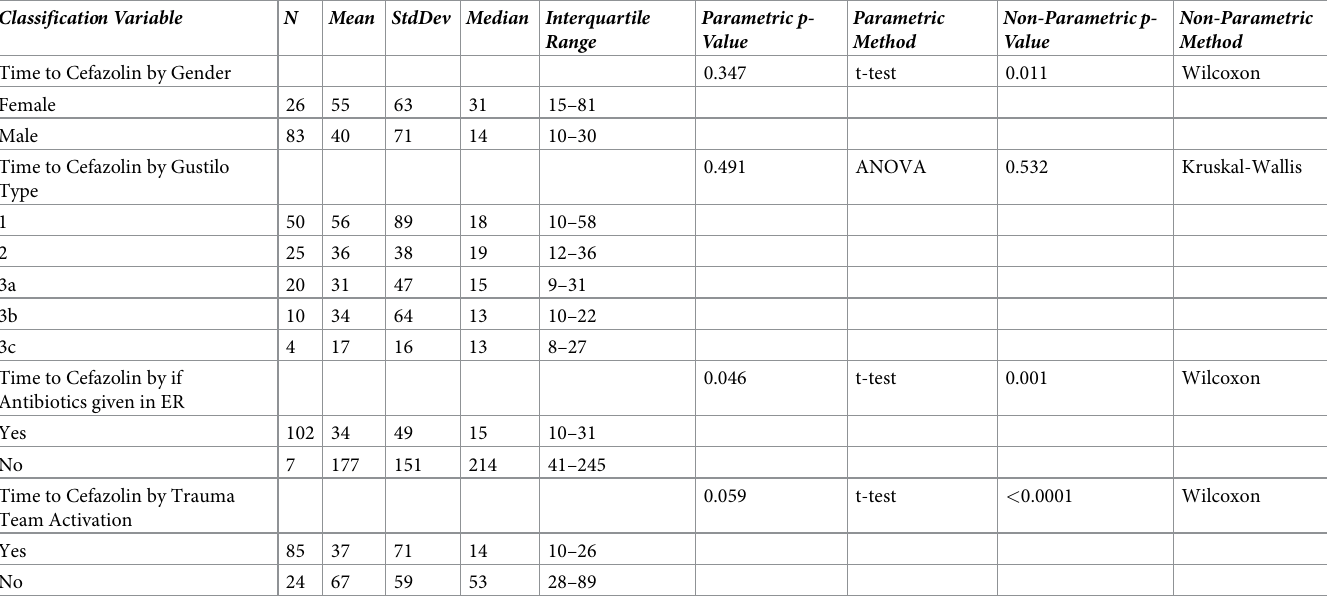
Table 2. Summary of timing to cefazolin